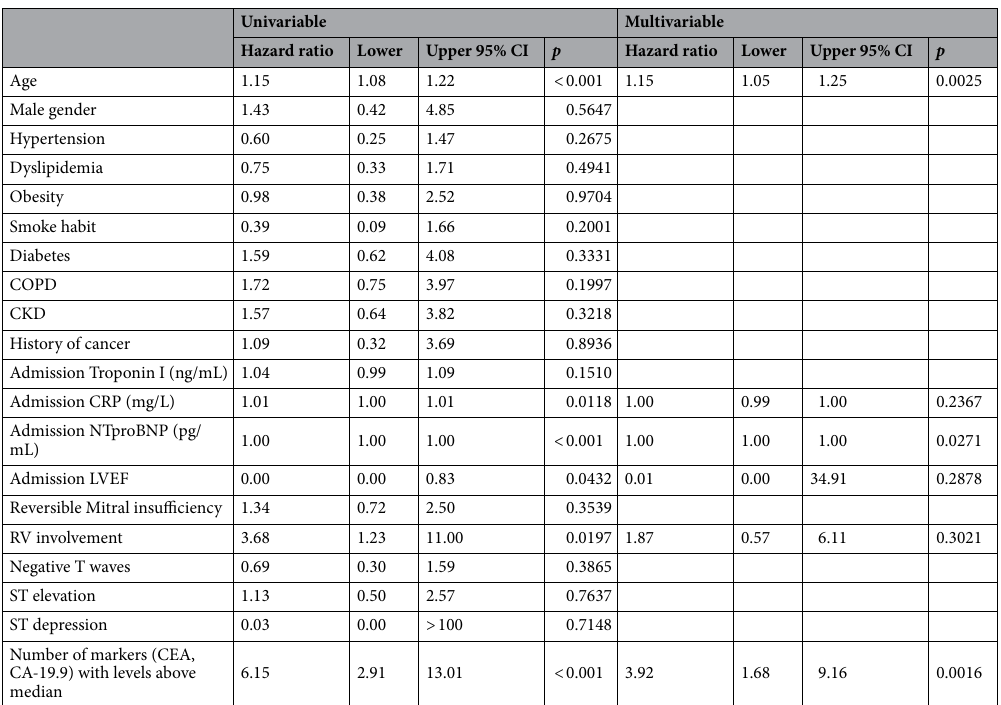
Table 3. Univariable and multivariable analysis, predictors of mortality at long-term follow up. COPD chronic obstructive pulmonary disease, CKD chronic kidney disease, CRP C-reactive protein, LVEF left ventricular ejection fraction, RV right